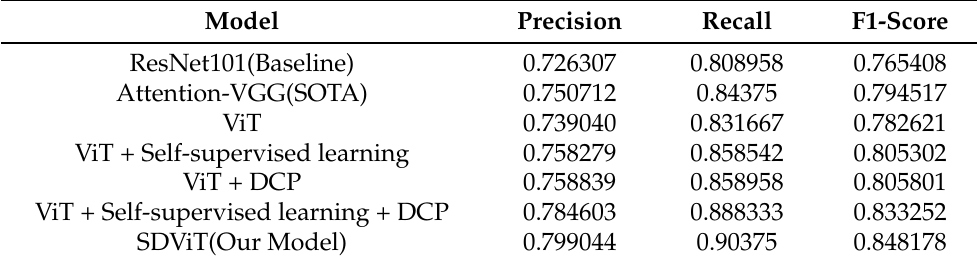
Table 9. Statistical metrics of different model configurations on synthetic-covid-cxr dataset.